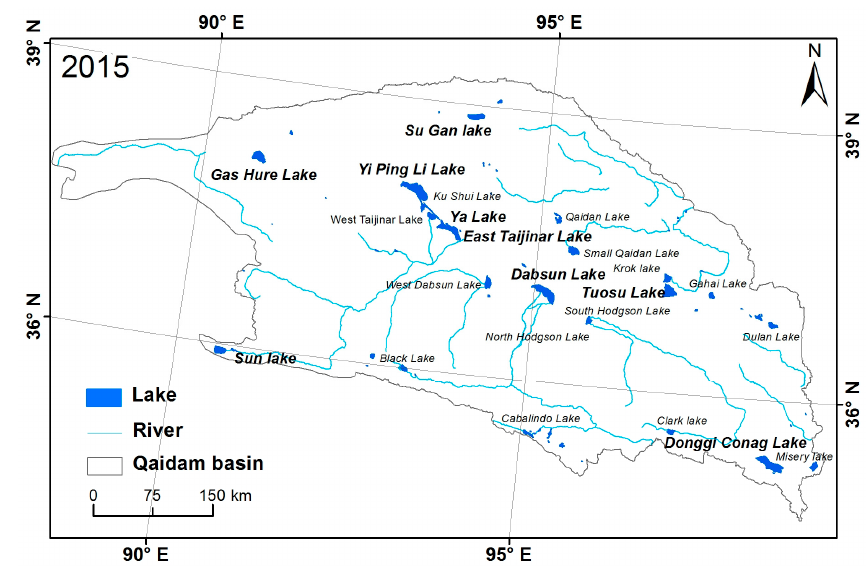
Figure 3. Spatial distribution of lakes in the Qaidam Basin (QB) in 2015. Only lakes with known names are labeled and the lakes with larger bold fonts have an area larger than 100 km 2 . The river dataset was derived from Geographic Information System (GIS) Basic Data of China (http://www.ngcc.cn/).